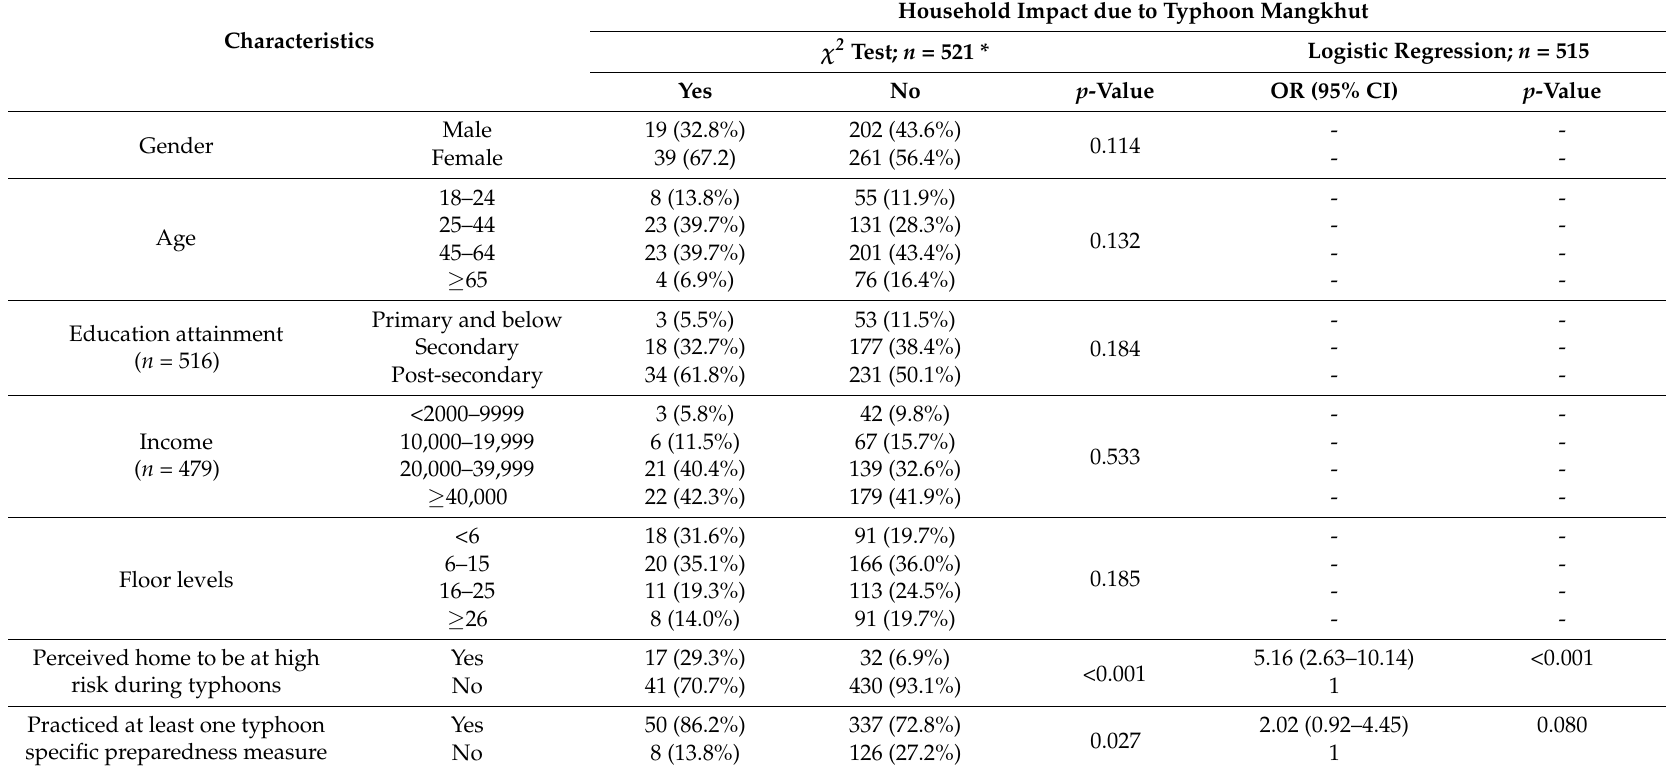
Table 4. The associating factors of typhoon household